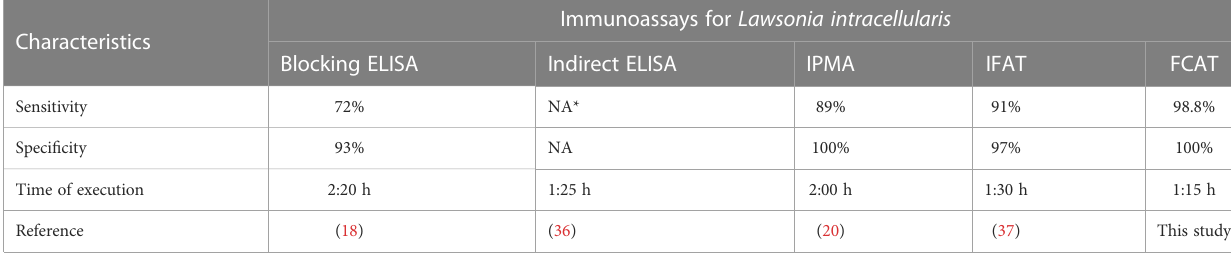
TABLE 5 Types and main characteristics of available serological assays for L. intracellularis .